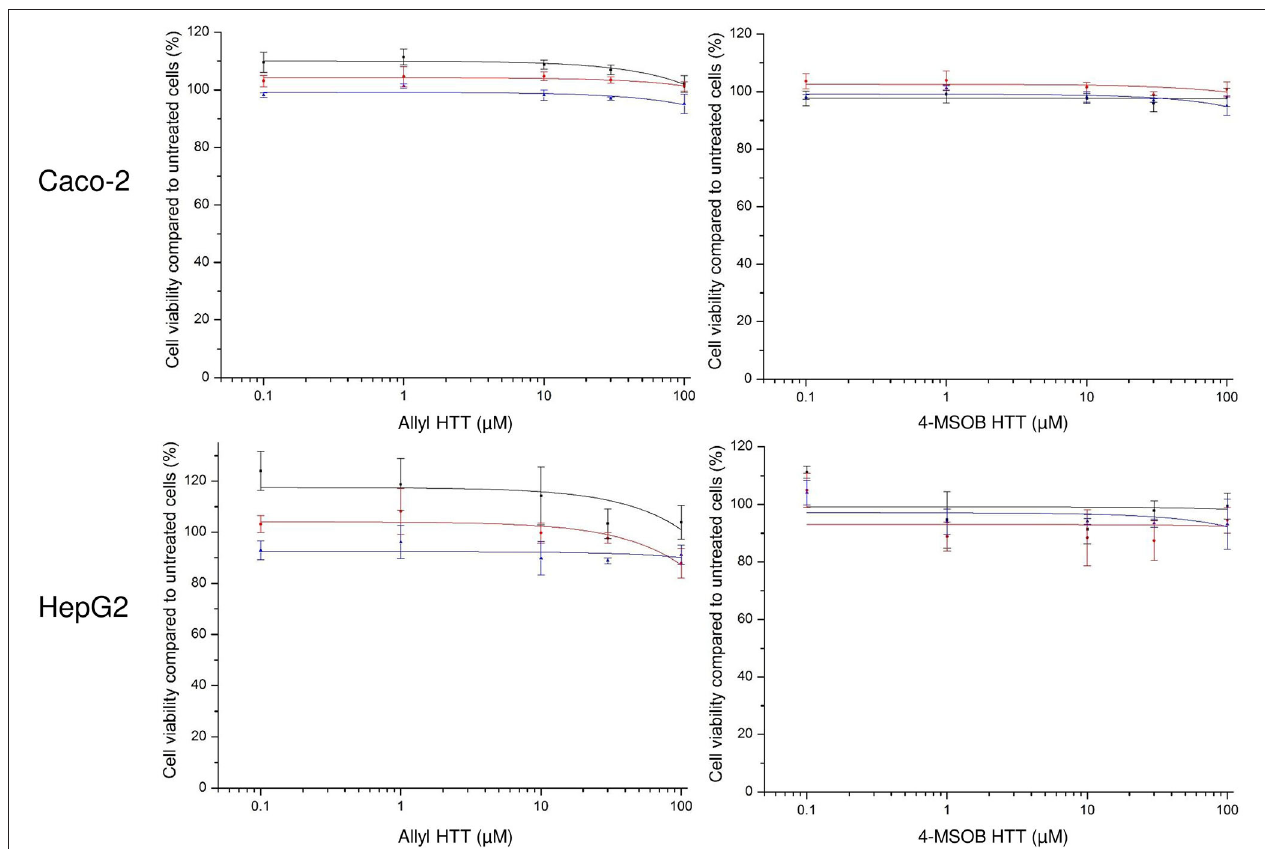
FIGURE 2 | Effect of 3-allyl-4-hydroxythiazolidine-2-thione (allyl HTT, left) and 4-hydroxy-3-(4-(methylsulfinyl)butyl)thiazolidine-2-thione (4-MSOB HTT, right) on cell viability of Caco-2 cells (above) or HepG2 cells (below) measured by neutral red uptake assay. Depicted as ratio between measured absorbance values for cells treated with analyte spiked medium vs. treated with non-spiked medium. Each data point represents mean ± SD of three technical replicates and each colored line represents an independent cell passage of the 3 biological